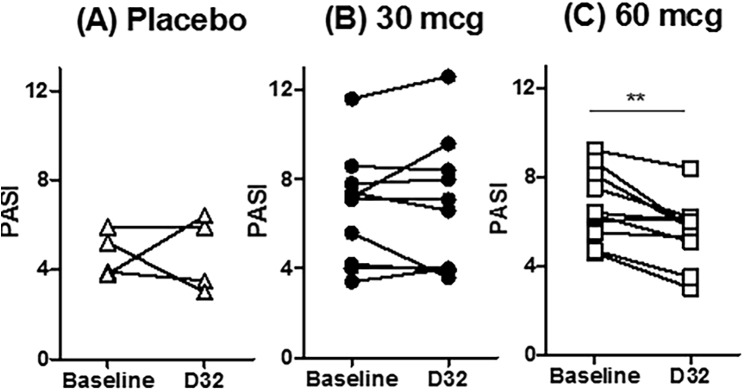
Individual PASI scores at baseline and Day 32.Placebo group (A), 30 mcg/dose group (B), and 60 mcg/dose group (C). *P < 0.01, two-tailed student’s t-test.